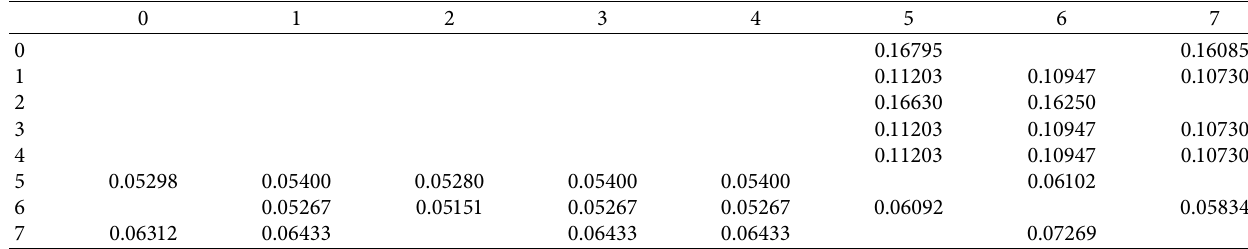
Table 10: Spread probability of each infected node at timeslot 3.